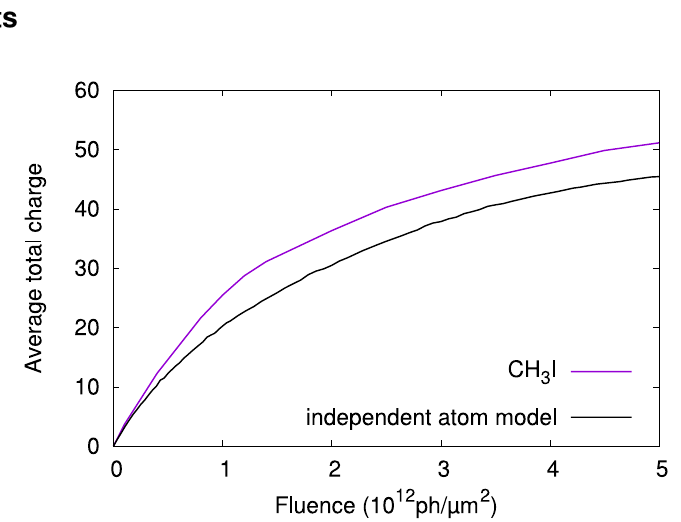
Figure 1. Average total charge as a function of fluence for the molecular calculation and the independent atom calculation.